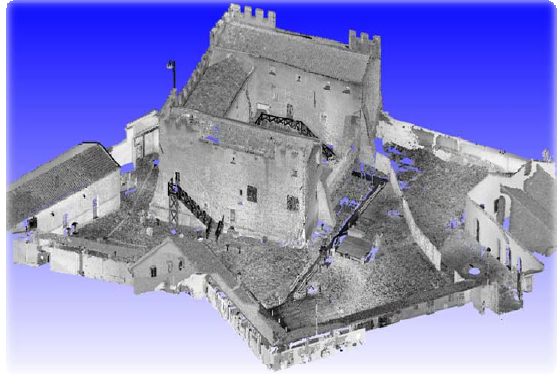
Fig. 9: Sivillier Castle 3D model